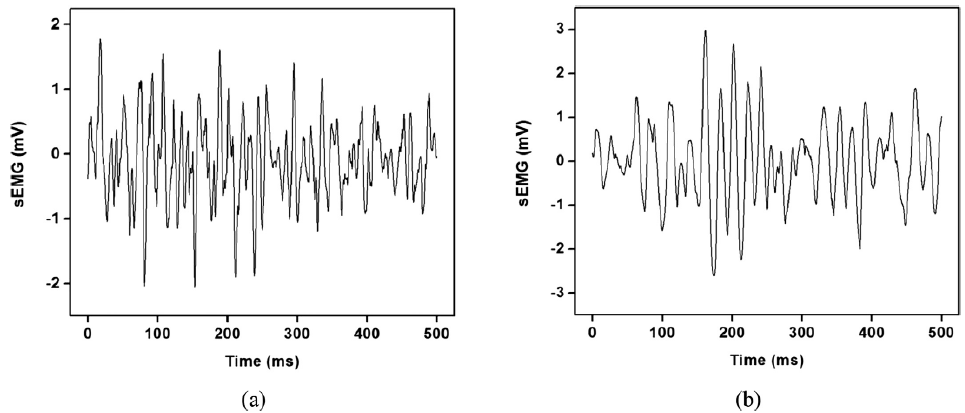
Figure 8. Representative ( a ) nonfatigue and ( b ) fatigue segment of sEMG signals.